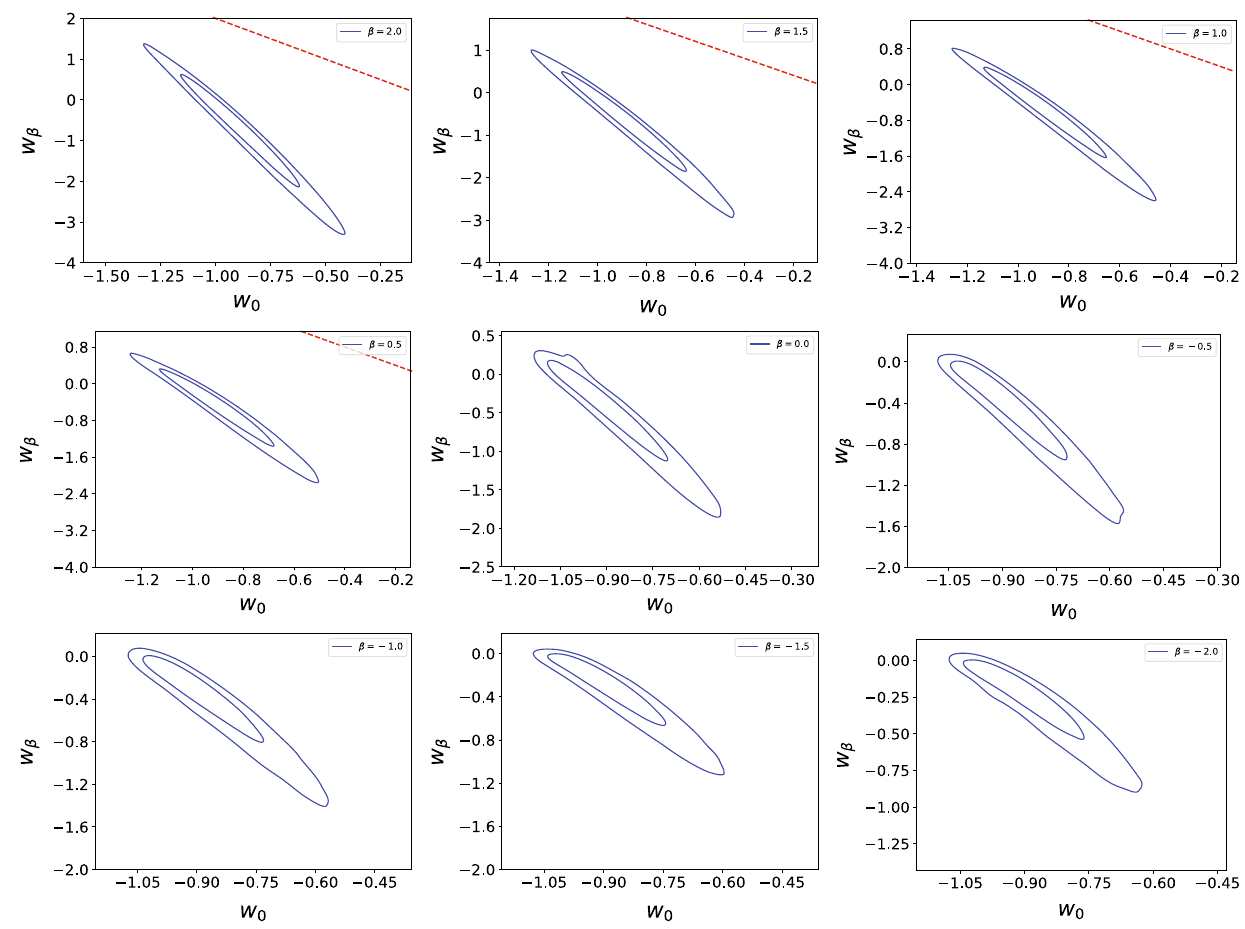
Fig. 2 The truncated planes w 0 – w β with different truncated β parameters. The special case with w 0 + w β /β = 0 denoted with red dashed lines is also added for comparison